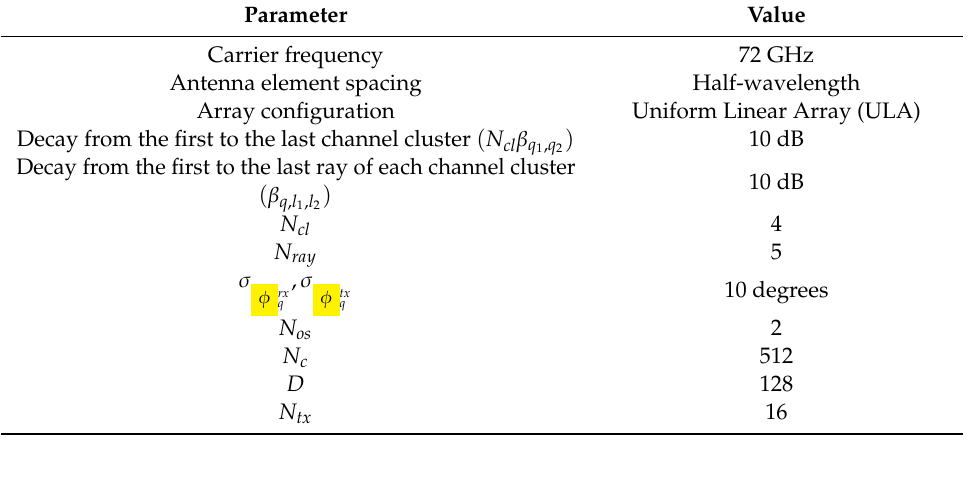
Figure 3. Performance comparison of the proposed iterative hybrid equalizer with 32 N = for different modulation indexes. rx